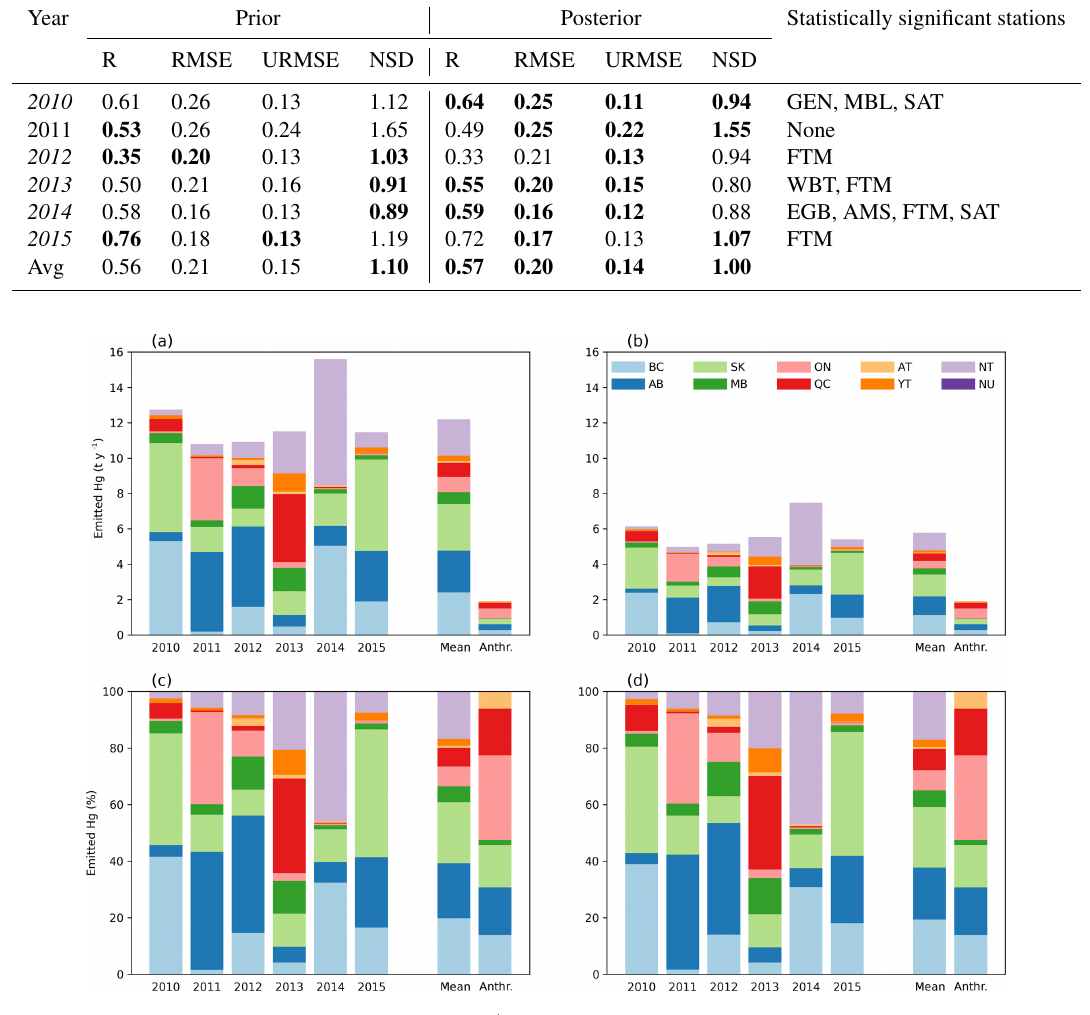
Figure 6. Prior (a) and posterior (b) mercury emissions (t year − 1 ) from biomass burning by province/territory for the burning season (May– September) for 2010–2015, the mean of the 6-year time period, and the anthropogenic emissions for the burning season. For biomass burning, only GEM is released, for anthropogenic emissions TOM species are also released. (c) As (a) but relative contribution. (d) As (b) but relative contribution. Provincial and territorial name abbreviations are given in the caption of Fig. 1. Because of their small contribution to the total, we group the Atlantic provinces (NB, NS, PE, and NL) together in one group,